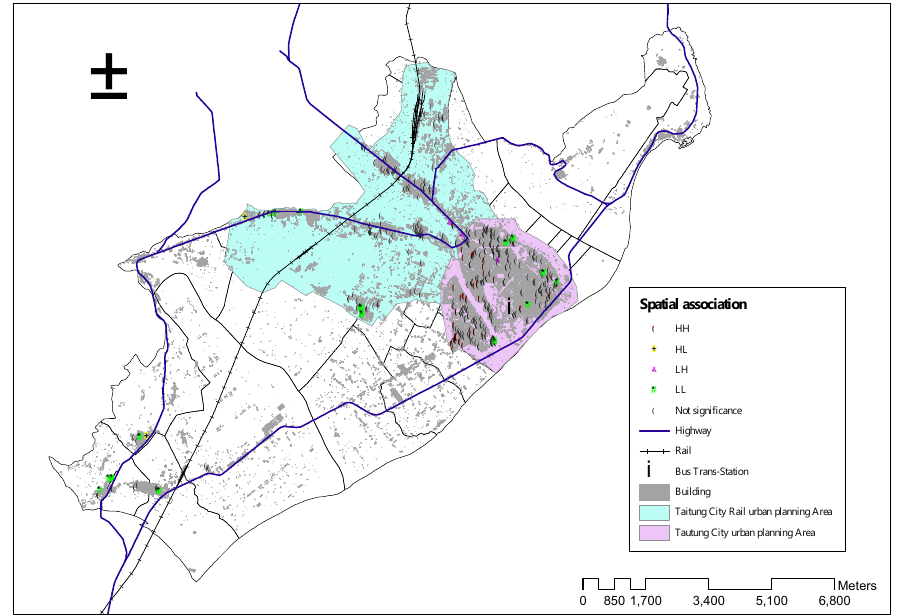
Figure 6. Spatial correlation map of real estate unit price in 2016.